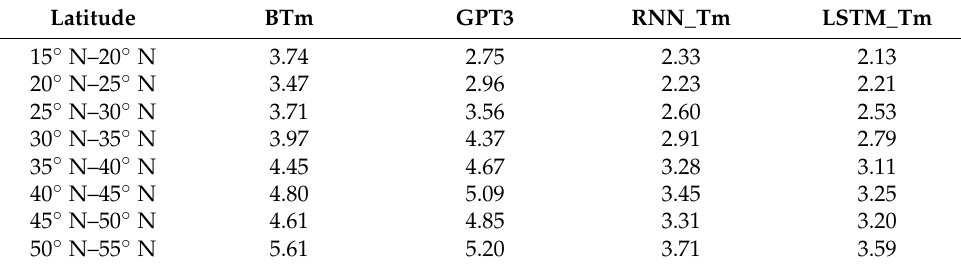
Table 4. RMSE of Various Models in Different Latitude Zones [K]. Latitude